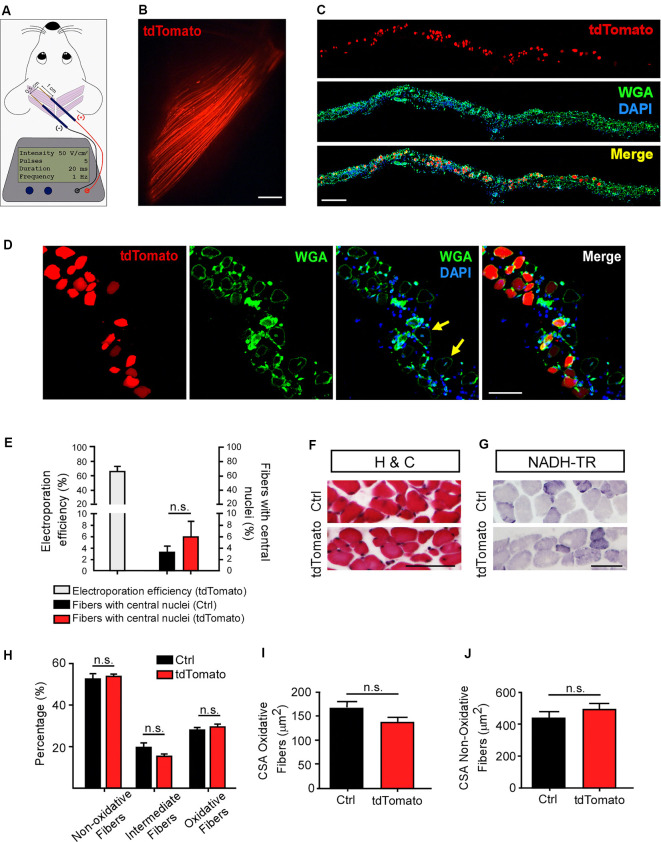
Efficient electroporation-mediated gene transfer of Levator auris longus (LAL) muscles. LAL muscles from adult mice were electroporated in vivo with a plasmid coding for the tdTomato protein. Plasmid DNA was injected underneath the LAL muscle fascia and gold needle-type electrodes were positioned above the muscle to deliver five pulses of 100 V/cm2 of 20 ms of duration at 1 Hz (A). After 21 days, dissected whole-mounted muscles (B) were transversally sectioned and stained with Alexa488-WGA (green) and DAPI (blue) (C) to label the muscle membrane and nuclei, respectively. (D) Higher magnification images were used to quantify the efficiency of the procedure [as the percentage of tdTomato-expressing fibers from total fibers quantified based on wheat germ agglutinin (WGA) staining] (E) and the presence of central nuclei (arrowheads), as a parameter of muscle fiber damage/regeneration (E). (F) Transversal cryosections stained with Hematoxylin/Chromotrope revealed no significant alterations in muscle fiber histology or mononuclear cell infiltration. (G) NADH-TR histochemical activity detection was used to analyze non-oxidative (light and middle blue) and oxidative (dark blue) fibers. The proportion of these fiber types was quantified and expressed as a percentage of total fibers in the region of interest (H). Also, the cross-sectional area (CSA) of oxidative (I) and non-oxidative (J) fibers was determined in >100 fibers per type in each Hemi-LAL. The results represent the mean ± SEM of N: three mice per group (control and electroporated). Scale bar 5 mm (B), 200 μm (C), 50 μm (D), 50 μm (F,G). p > 0.05, t-test; n.s.= non-significant.